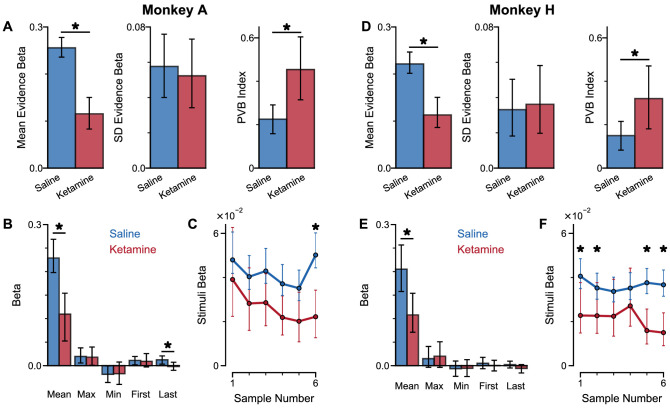
Behavioural effects of ketamine on the pro-variance bias and temporal weightings are not explained by lapsing.Results from Figure 8—figure supplement 1 are replicated with an extended model which included a lapse term. (A) Ketamine injection impairs the behaviour of Monkey A, in a manner consistent with the prediction of the lowered E/I circuit model. (Left) The coefficient for mean evidence, under injection of saline or ketamine. Ketamine significantly reduces the coefficient (permutation test, p<0.0001) reflecting a drop in choice accuracy. (Middle) The coefficient for evidence standard deviation, under injection of saline or ketamine. Ketamine does not significantly reduce the coefficient (permutation test, p=0.636). (Right) Ketamine increases the PVB index (permutation test, p=0.0006), consistent with the model prediction of the lowered E/I circuit. (B) The regression model using mean, maximum, minimum, first, and last evidence values of each of the left and right streams as regressors, under injection of saline or ketamine. Each bar shows the average of the left and right regressors of the corresponding variable. Ketamine injection does not alter decision-making strategies. Black asterisks denote a significant difference between saline and ketamine conditions at the respective regressor (permutation test, p<0.05). (C) The weights of stimuli at different time-steps, for Monkey A with saline or ketamine injection. Ketamine injection lowers the curve of temporal weights, consistent with the lowered E/I circuit model. Black asterisks denote a significant difference between saline and ketamine conditions at the respective sample number (permutation test, p<0.05). (D–F) Same as (A–C) but for Monkey H. (D) Ketamine significantly reduces the coefficient for mean evidence (permutation test, p<0.0001), does not significantly reduce the coefficient for evidence standard deviation (permutation test, p=0.731), and significantly increases the PVB index (permutation test, p=0.0056). All errorbars denote the 95% confidence interval generated through a bootstrap procedure.